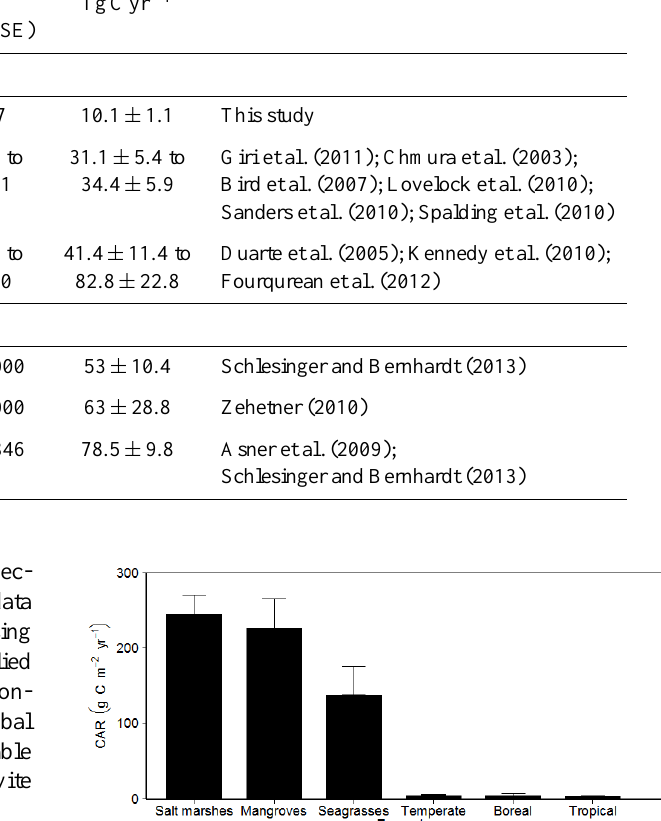
Table 5. Comparison of carbon accumulation in sediments and soils of salt marshes and other ecosystems. ND – no data. Ecosystems